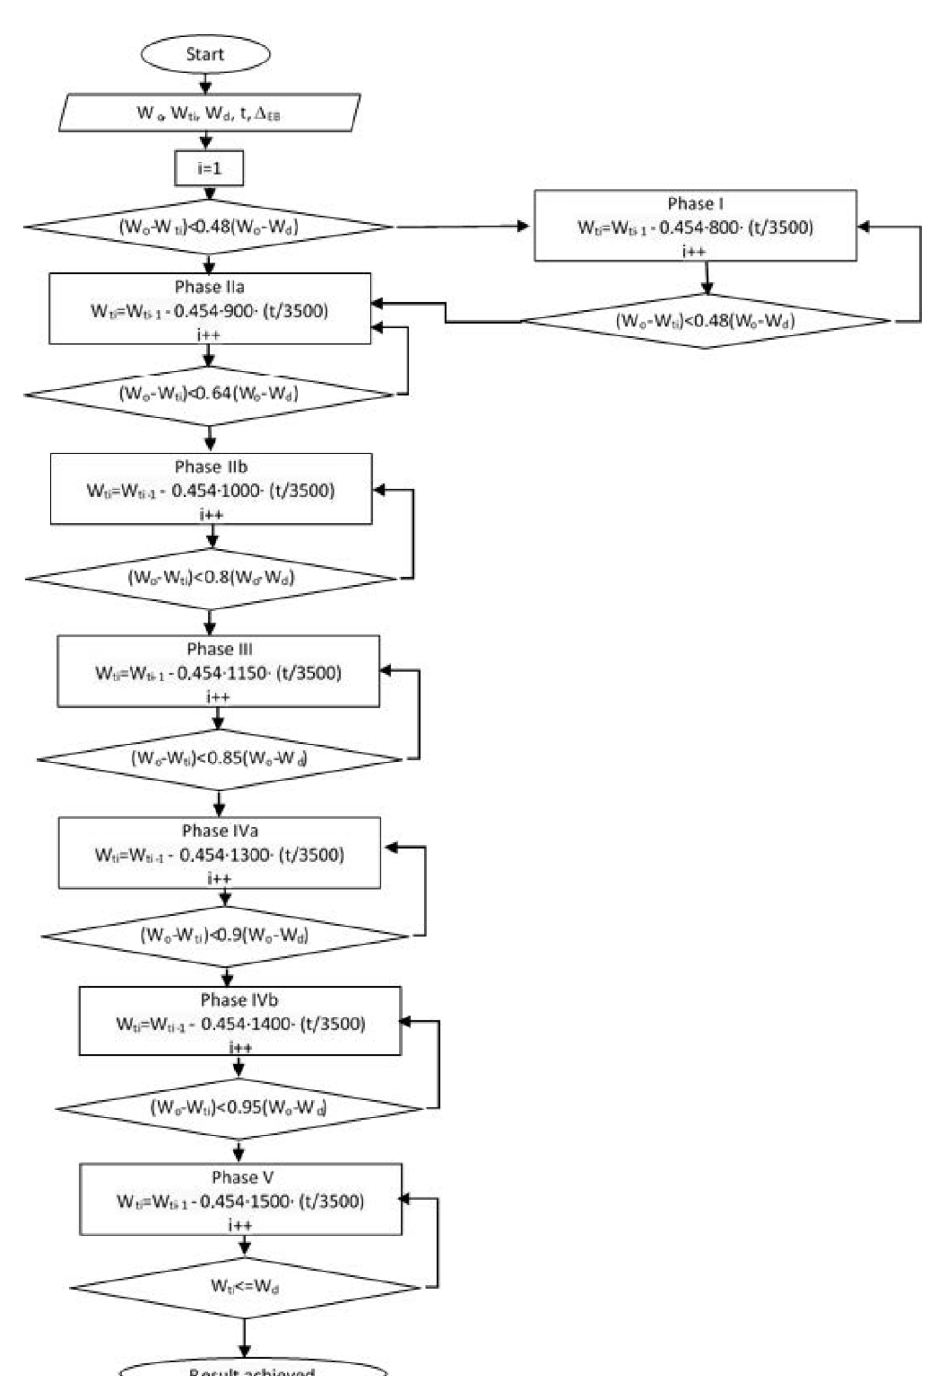
Figure 1. This is a figure. Schemes follow the same formatting. Figure 1. Flow chart presenting ketogenic diet